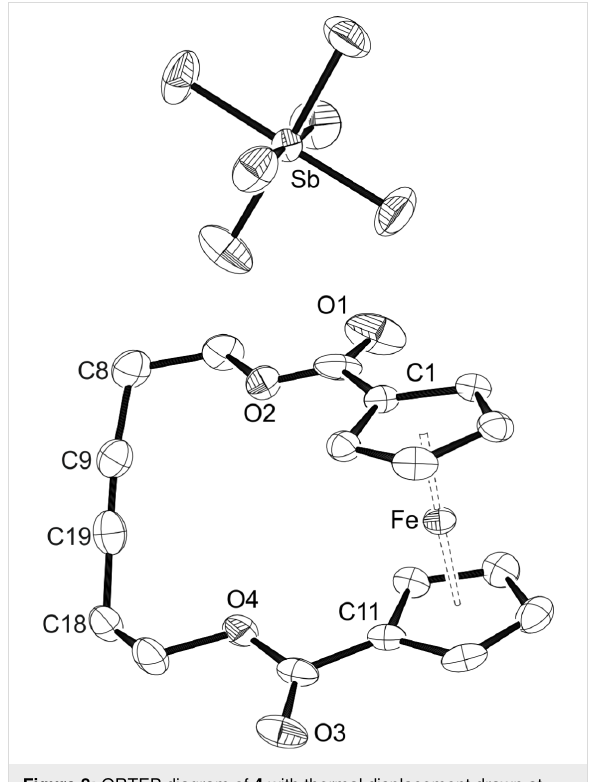
Figure 8: ORTEP diagram of 4 with thermal displacement drawn at 50% probability; hydrogen atoms are omitted for clarity. Disordered po- sitions from O2 to C19, only the main component is shown. Selected bond lengths [Å] and angles [°]: Fe–Ct1 1.7100(4), Fe–Ct11 1.7131(4), Ct1–Fe–Ct11 178.11(3).